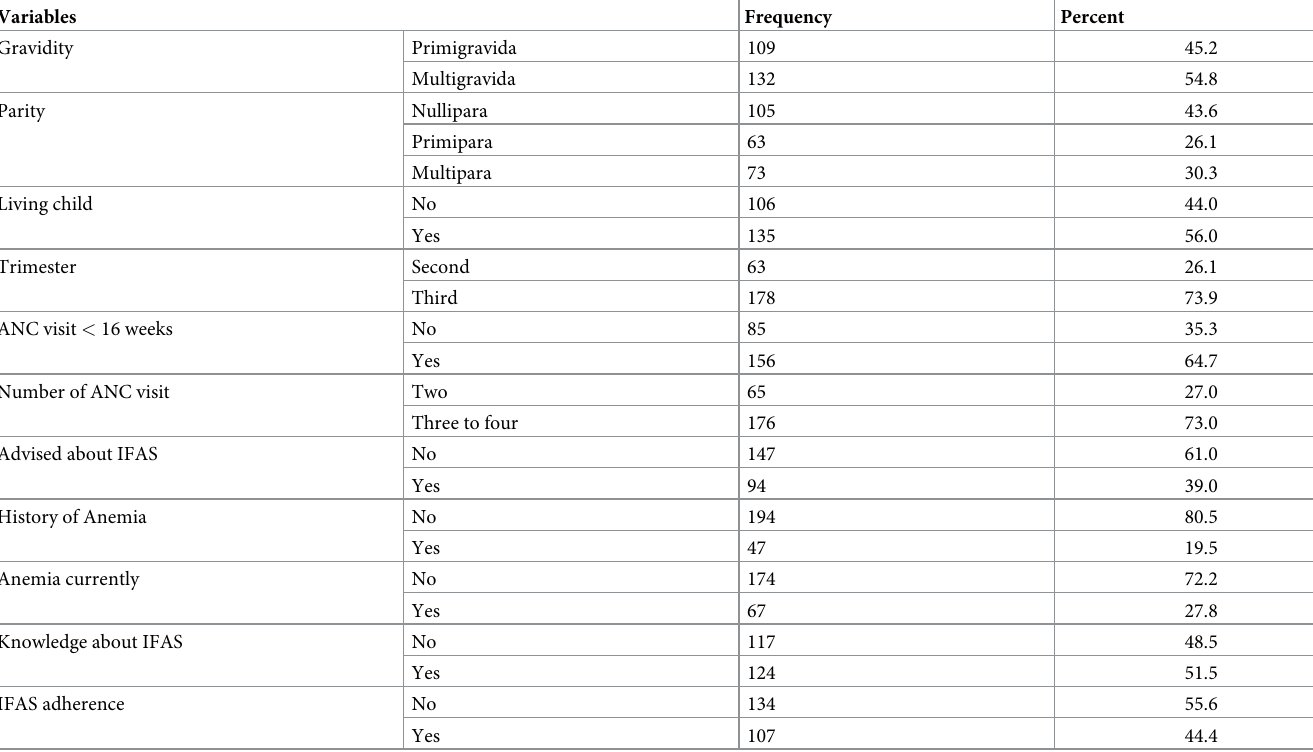
Table 2. Obstetrics and health-related characteristics of pregnant women attending ANC service at Debre Tabor General Hospital, North West Ethiopia, 2017.